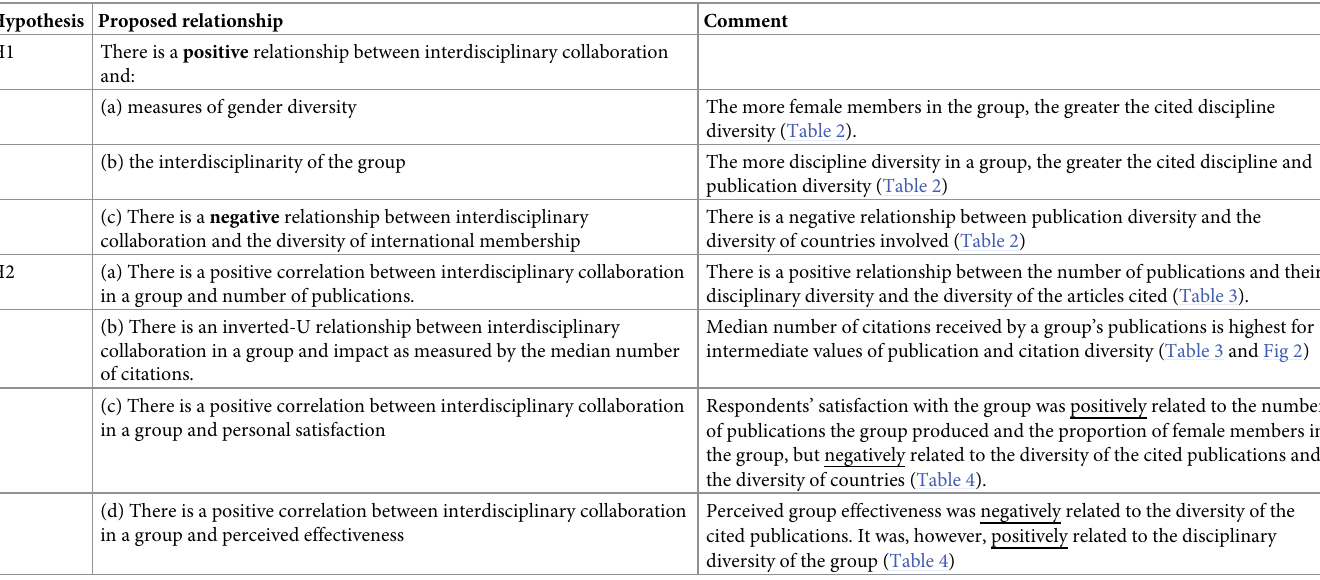
Table 5. Summary of the outcome of the hypothesis tests.